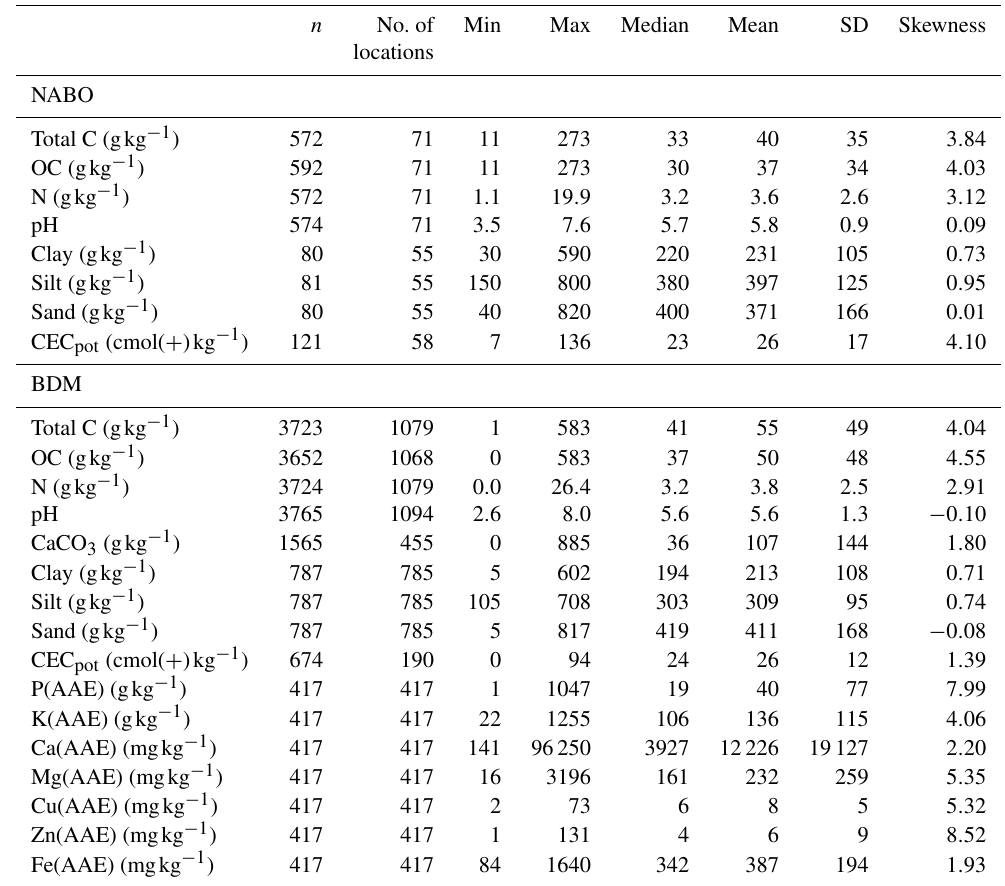
Table 1. Summary statistics of the measured soil properties of the Swiss soil spectral library derived from the sample archive of the Swiss Soil Monitoring Network (NABO) and the Swiss Biodiversity Monitoring (BDM) program. Total C is total carbon, OC is organic carbon and CEC pot is potential cation exchange